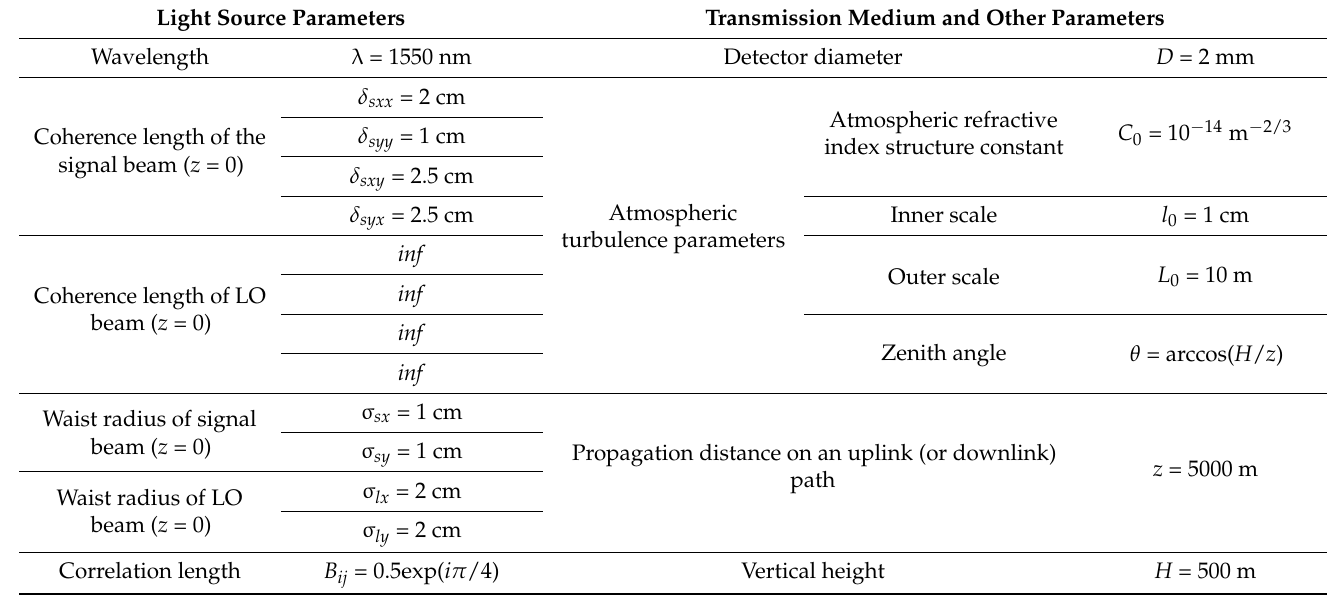
Table 1. Simulation parameter